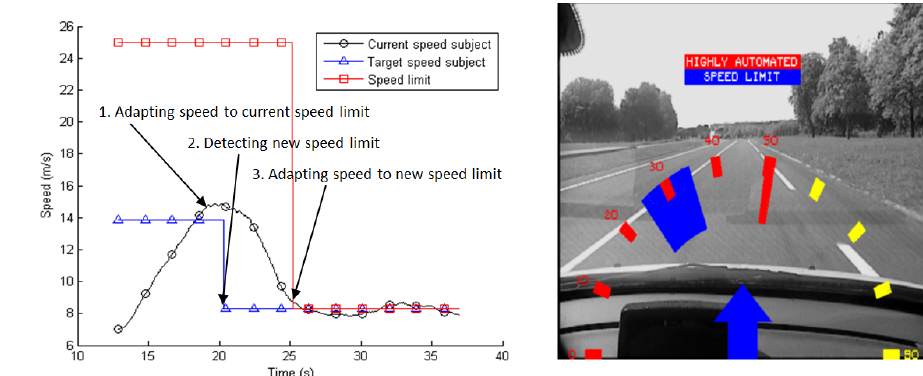
Figure 13. “Approaching a speed limit” scenario.